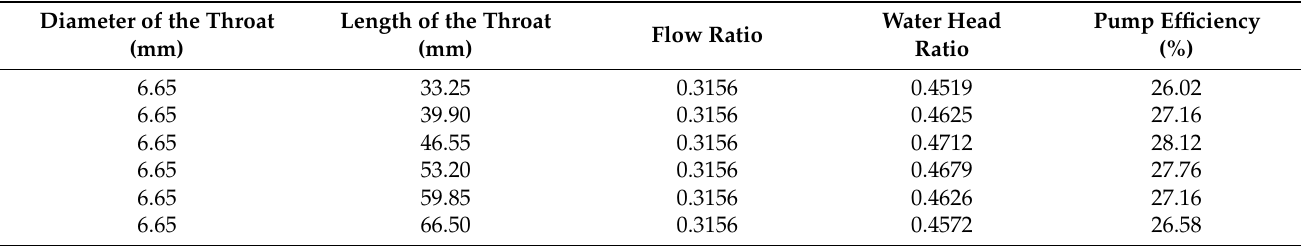
Figure 7. Velocity cloud diagrams of the throat outlet with different area ratios. Table 6. Effect of different throat length–diameter ratios on pump